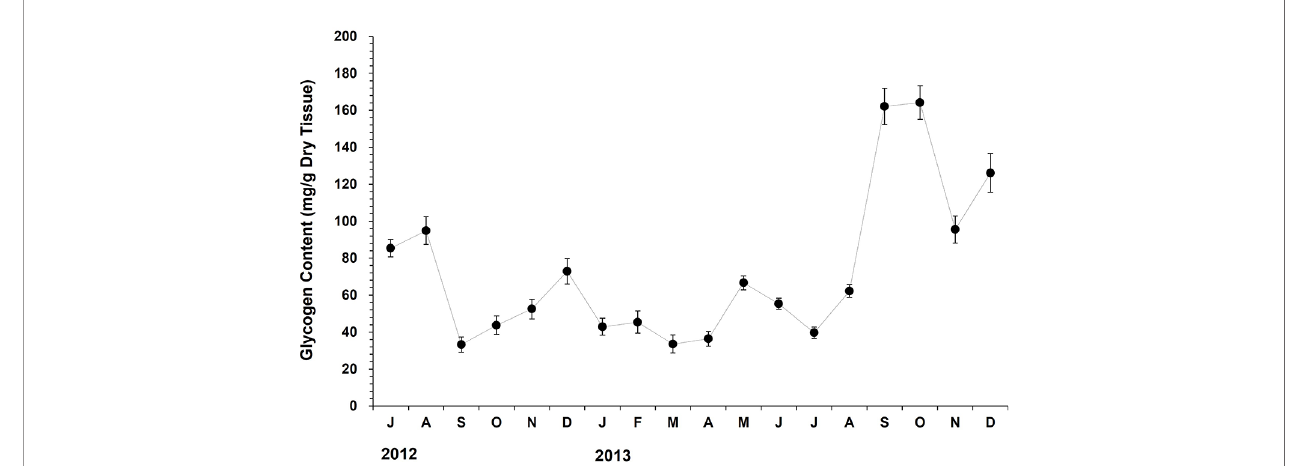
FIGURE 7 | The monthly variation in the tissue glycogen content of the off-bottom rack cultured oysters at the Euhangri beach from July 2012 to December 2013. The vertical bars on the monthly mean represent the standard